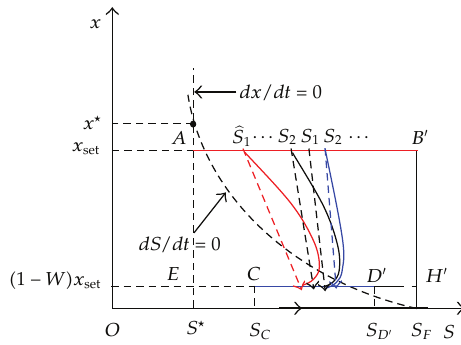
(cid:22) S 0 > S (cid:2) .